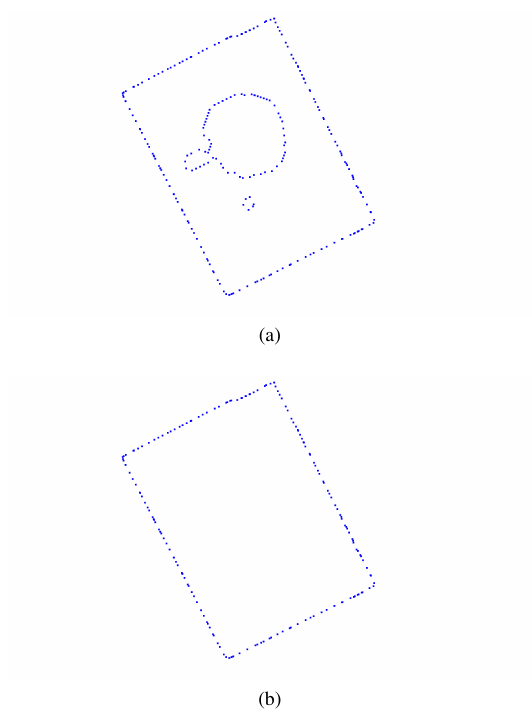
Figure 11: Point cloud of the previous example model border, with and without the internal